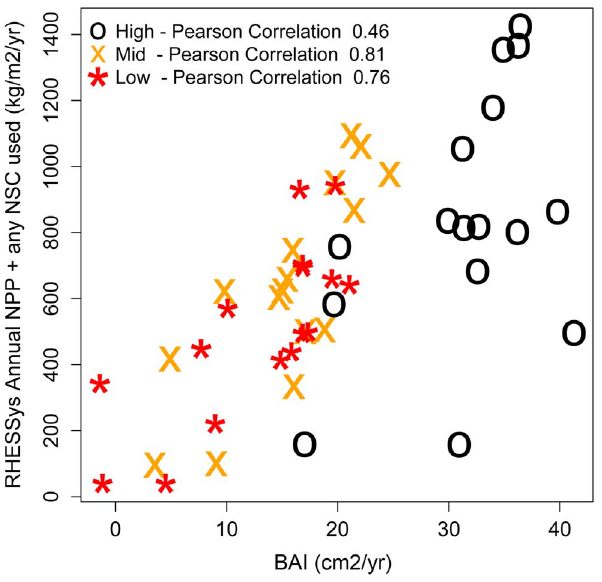
Figure 4. Comparison between observed basal area increment (BAI) and RHESSys estimates of annual net primary productiv- ity (NPP). Points compare observed BAI and model NPP estimates for each year for the 1992–2007 period. Note in the NPP estimate we include the addition of any NSC that was removed from long term storage in a given year and used for growth. Here we report Pearson correlation coefficients using 0.3 and 0.05 for NSC/NPP and MinL/AGC, respectively. All correlation coefficients have p-value , 0.05. Table 2 provides mean and range of correlation coefficients for all NSC parameter